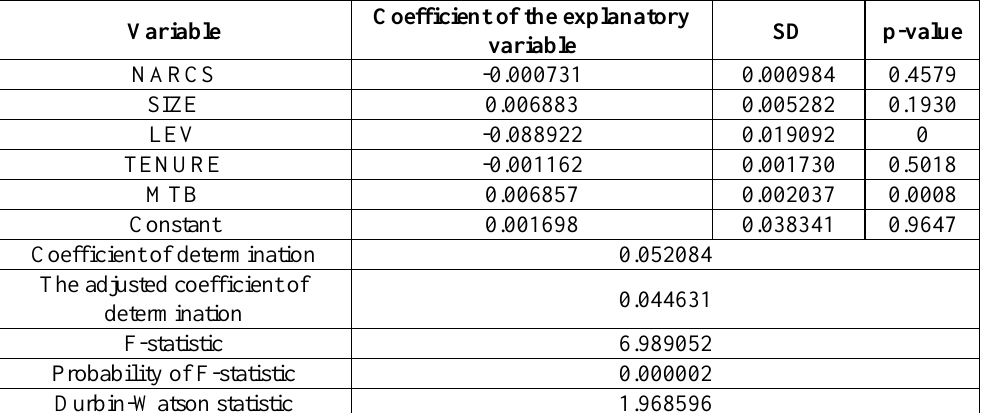
Table 6. Model fit for